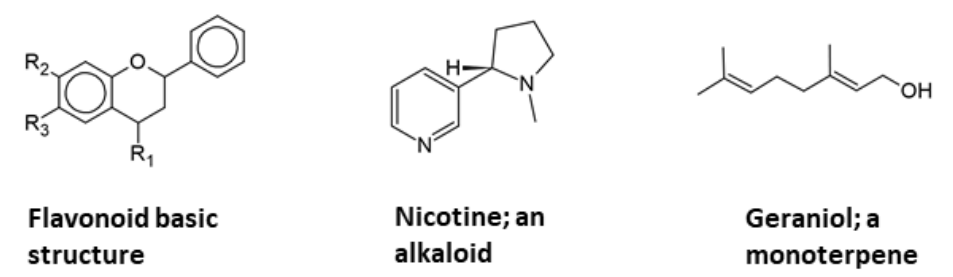
Figure 3. The chemical structure of major classes of phytochemicals.